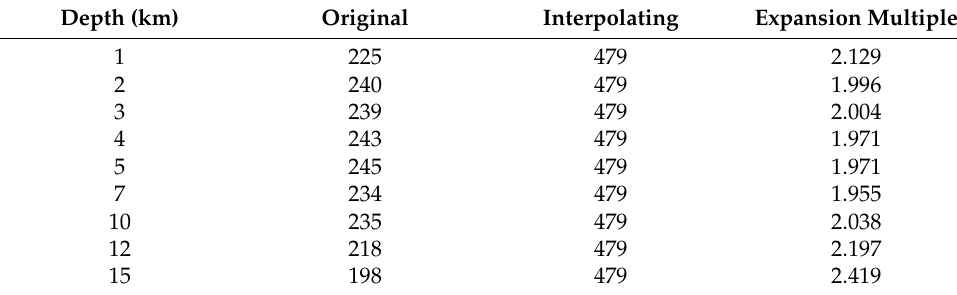
Table 3. Expansion multiple at each